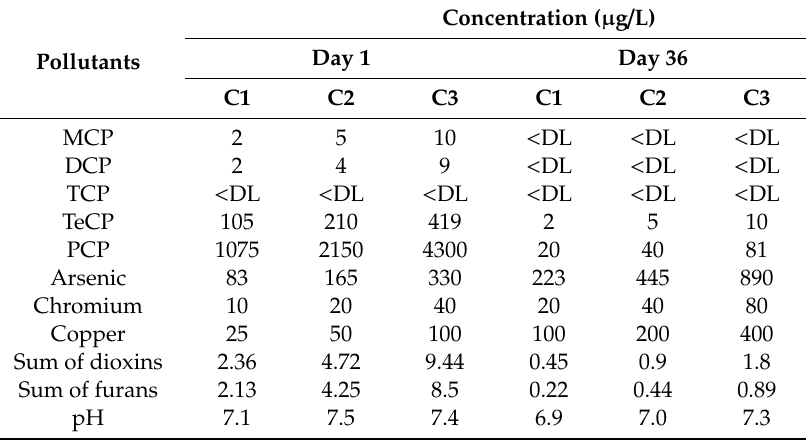
Table 1. Concentration of pollutants ( µ g / L) in C1–C3 leachates on day 1 and day 36 of the experiment. (MCP) monochlorophenols, (DCP) dichlorophenol, (TCP) trichlorophenol, (TeCP) tetrachlorophenol, (PCP) pentachlorophenol, (DL) detection